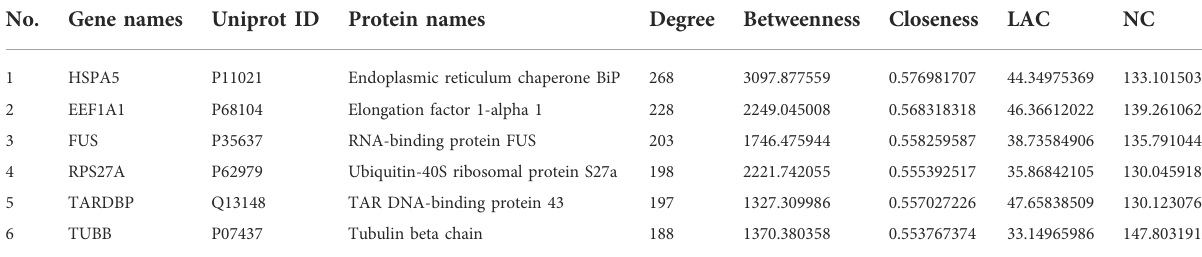
TABLE 2 Core target information of Ligusticum chuanxiong-Piper longum couplet medicines in the treatment of migraine. No.